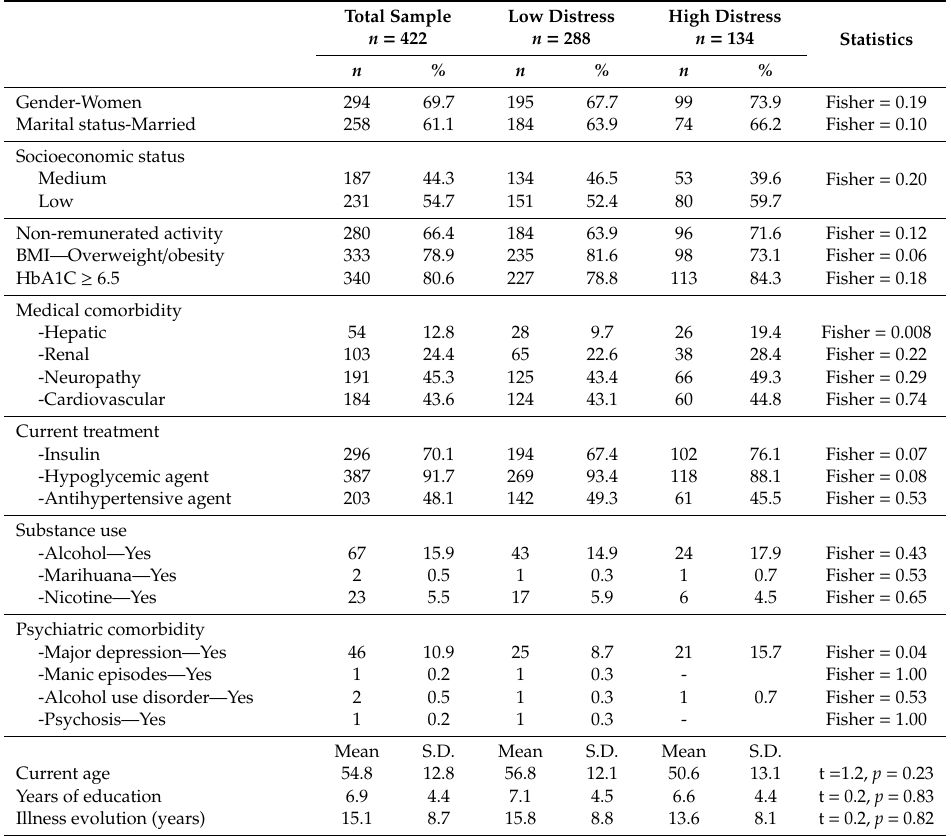
Table 1. Demographic and clinical features according to emotional distress